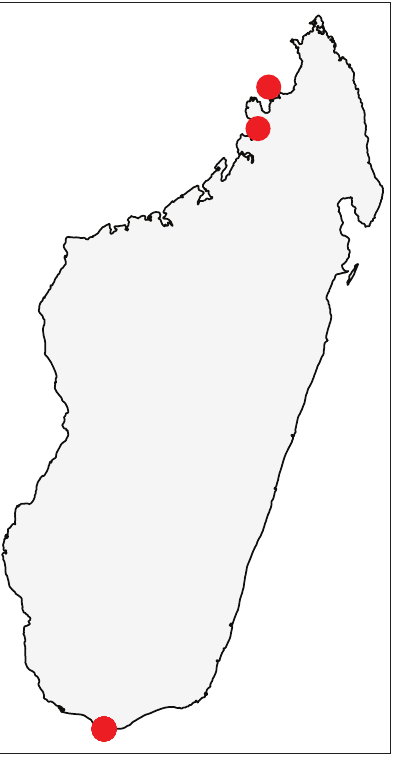
Figure 29. Geographic distribution of Nesomyrmex flavigaster sp. n.. The known localities of N. flavi- gaster sp. n. in